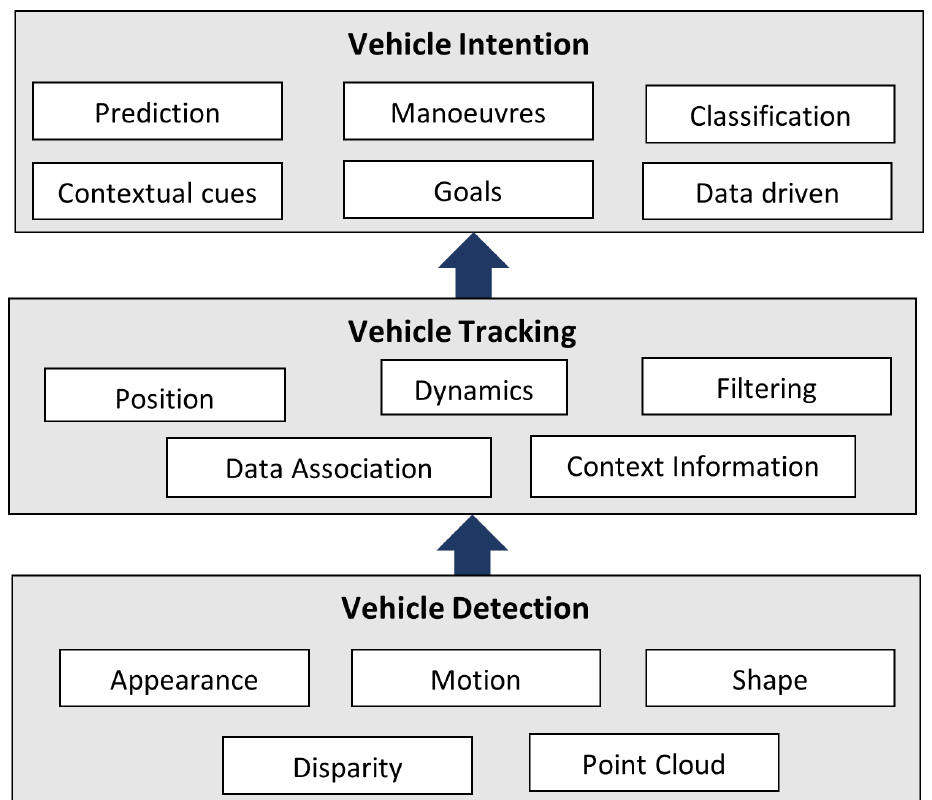
Figure 13. Block diagram to present the stages of vehicle detection, vehicle tracking, and vehi- cle behaviour. The vehicle detection is performed using appearance, motion, shape, point cloud, and disparity techniques. Vehicle tracking is acquired using position, dynamics, filtering, context information, or data association. The vehicle behaviour is determined using manoeuvres, contextual cues, data driven, or goal-orientated approaches